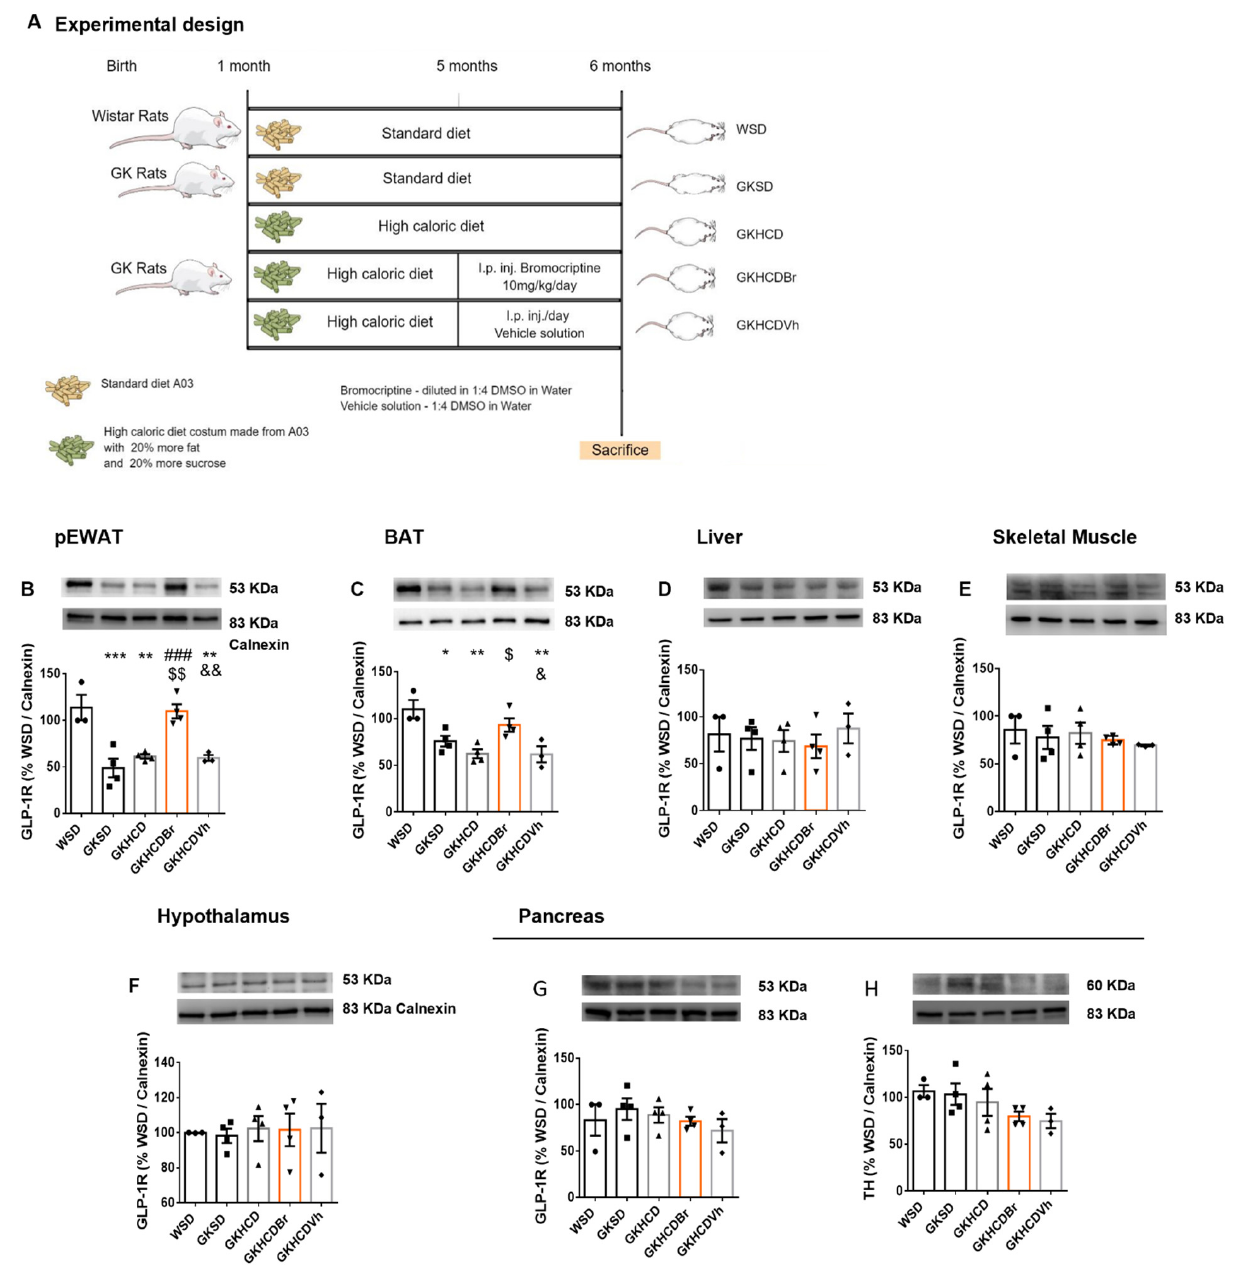
Figure 5. GLP-1 signaling in peripheral tissues after D2R agonist, Bromocriptine treatment in lean and obese type 2 diabetic rats. Type 2 diabetic rats fed a high-caloric diet treated with bromocriptine (experimental design depicted in ( A )) presented increased levels of GLP1-R in both pEWAT (pEWAT, ( B )) and brown adipose tissue (BAT, ( C )) compared with lean and obese type 2 diabetic animals GKSD, GKHCD, and GKHCD_Vh. Bromocriptine treatment did not elicit this effect in the liver ( D ), muscle ( E ), and hypothalamus ( F ), and thus GLP1-R levels were similar between groups. In the pancreas, both GLP1-R and TH levels remained unchanged between groups ( G , H ). Bars represent means ± SEM. Differences between groups were assessed by one-way ANOVA test with Tukey post-hoc corrections for multiple comparisons. Symbols represent: * Different from WSD; # different from GKSD; $ different from GKHCD; & different from GKHCD_Br. Level of significance: 1 symbol, p < 0.05; 2 symbols, p < 0.01; 3 symbols, p < 0.001.